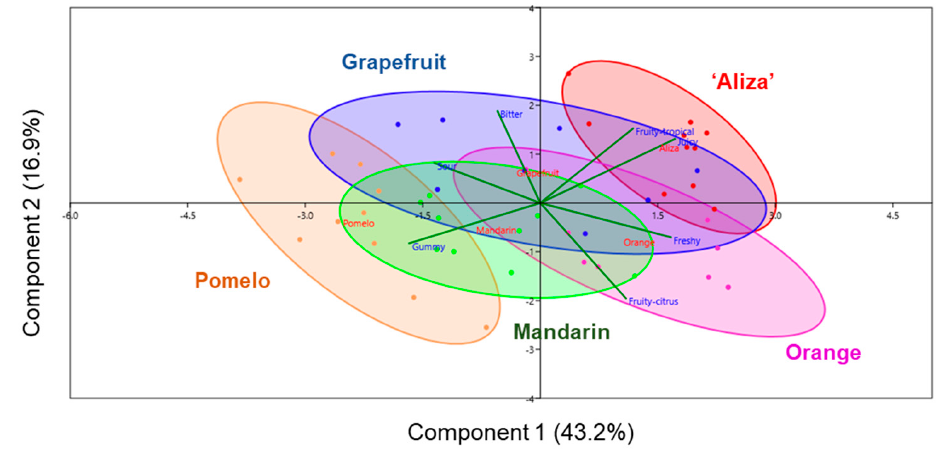
Figure 4. Biplot PCA chart of descriptive sensory data for ‘Aliza’, grapefruit, pomelo, orange and mandarin. The marked ellipses indicate the 95% probability that a new observation from the same group will fall inside the ellipse.